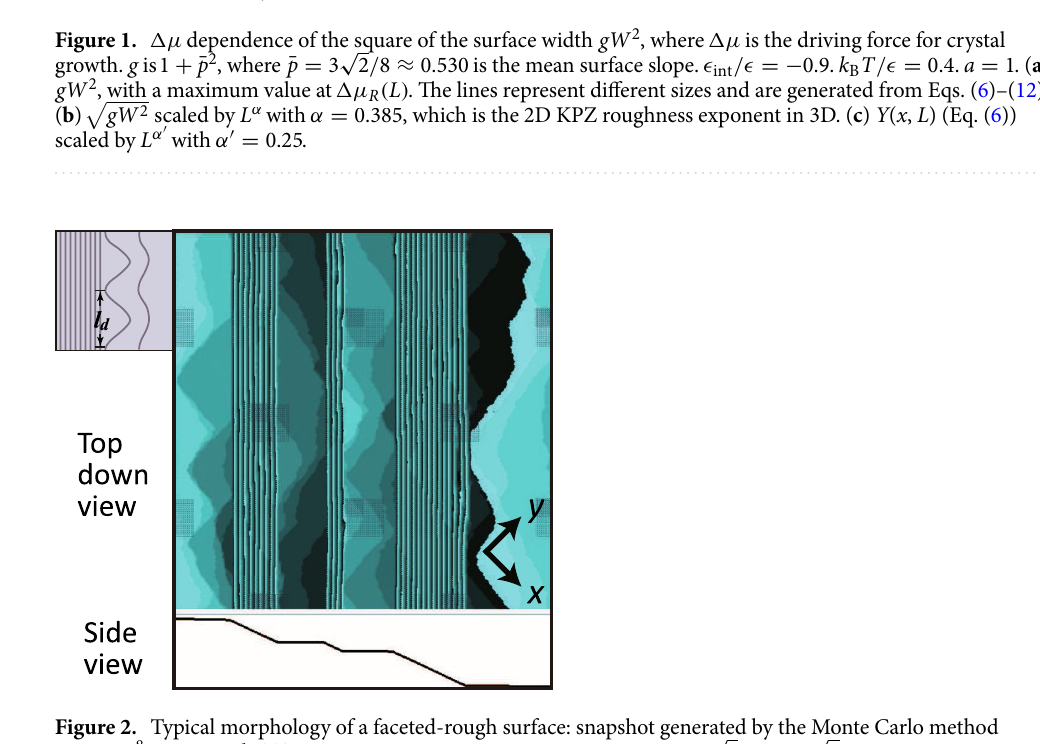
300 . 400 √ 2 a . N step = ×